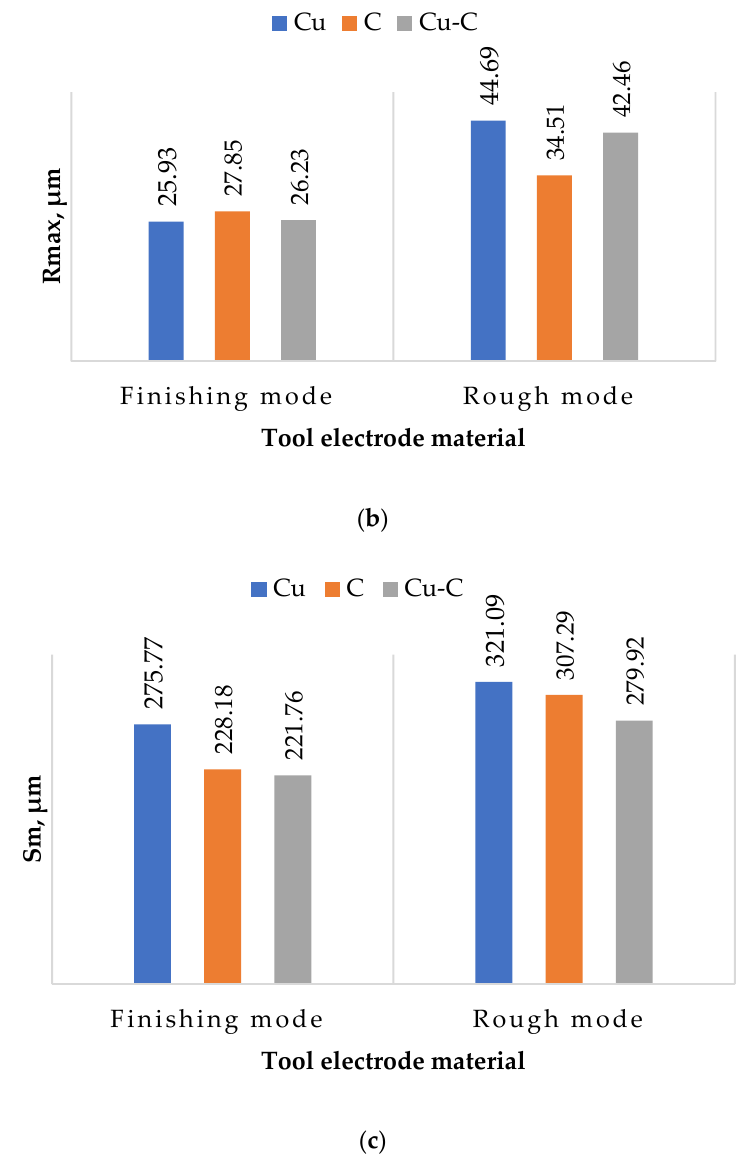
Figure 18. Histograms of surface roughness parameters after EDM with different ETs: ( a ) average roughness height (Ra); ( b ) maximum roughness height (Rmax); ( c ) average roughness pitch (Sm).